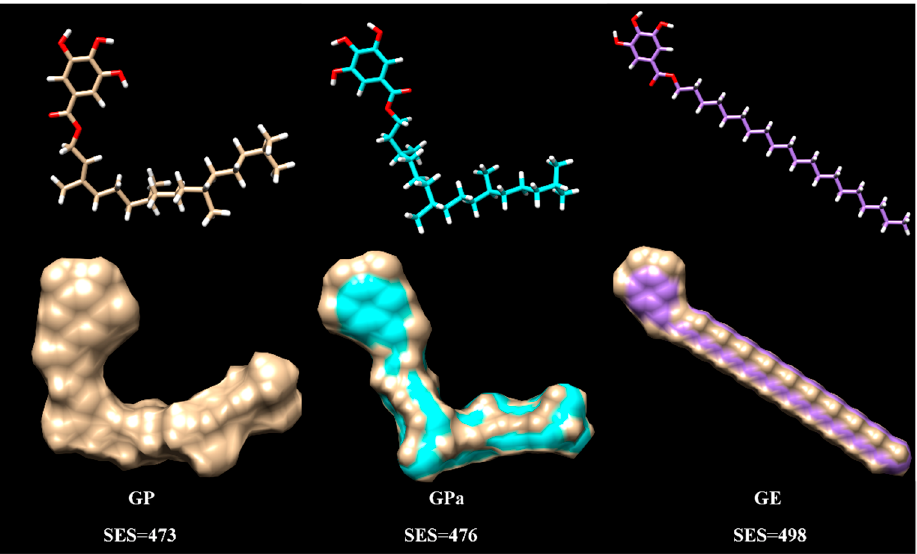
Figure 9. Molecular modeling of galloyl phytol (GP), galloyl phytanol (GPa), and galloyl eicosanol (GE).